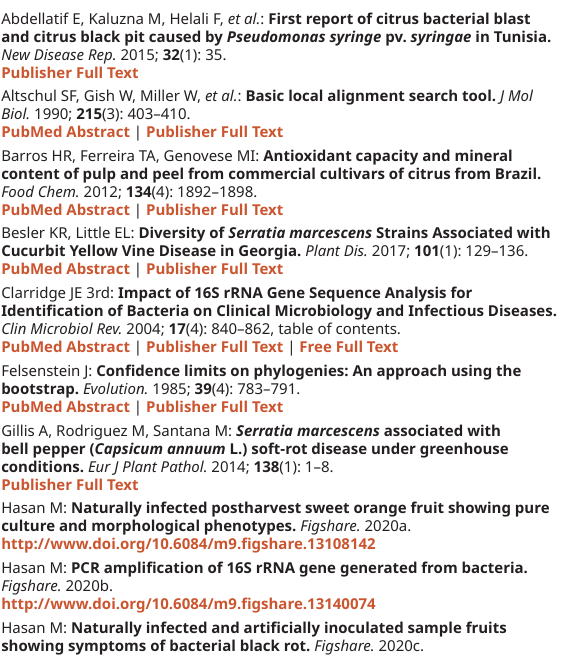
Figshare: Antagonistic activity of soil born bacteria against the isolate BS2, https://doi.org/10.6084/m9.figshare.13108061 (Hasan,